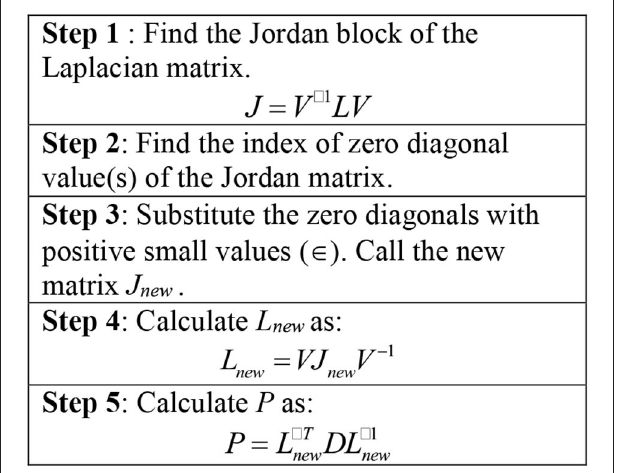
FIGURE 4 | The steps to calculate the Positive semi-definite matrix P